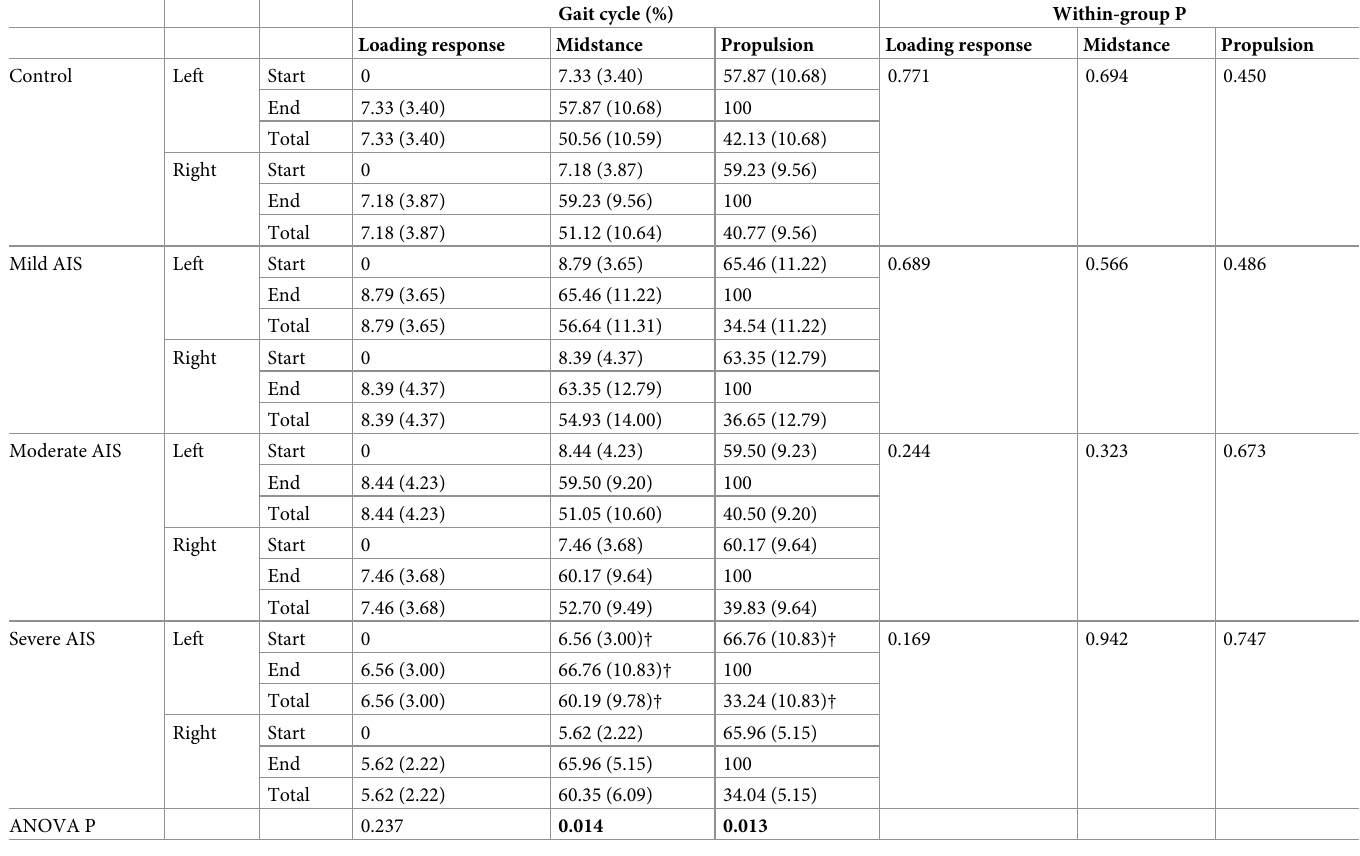
Abbreviations: AIS, adolescent idiopathic scoliosis; ANOVA, one-way analysis of variance; within-group, within-group comparison. † Significant difference compared to the control group (P <